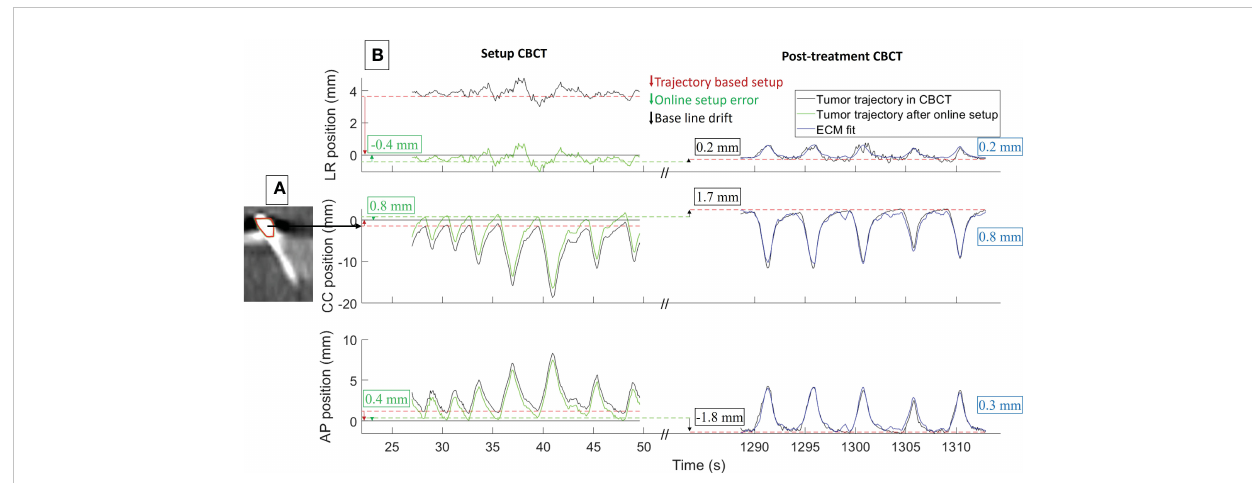
FIGURE 3 Example of (A) reconstructed CBCT and (B) tumor motion during CBCT (patient 3, fraction 3). (A) Blurred marker in the setup CBCT scan and the online registration to the planned exhale marker position (red contour). (B) Estimated 3D tumor trajectories during setup CBCT and post-treatment CBCT relative to the planned position (black curves), tumor trajectory in setup CBCT after online registration and couch correction (green curves), and external-internal correlation model (ECM) fi t for the post-treatment CBCT (blue curves). The numbers show the online registration error (green), intrafraction baseline drift (black), and root mean square error of ECM fi t (blue). LR, left-right; CC, cranio-caudal; AP,